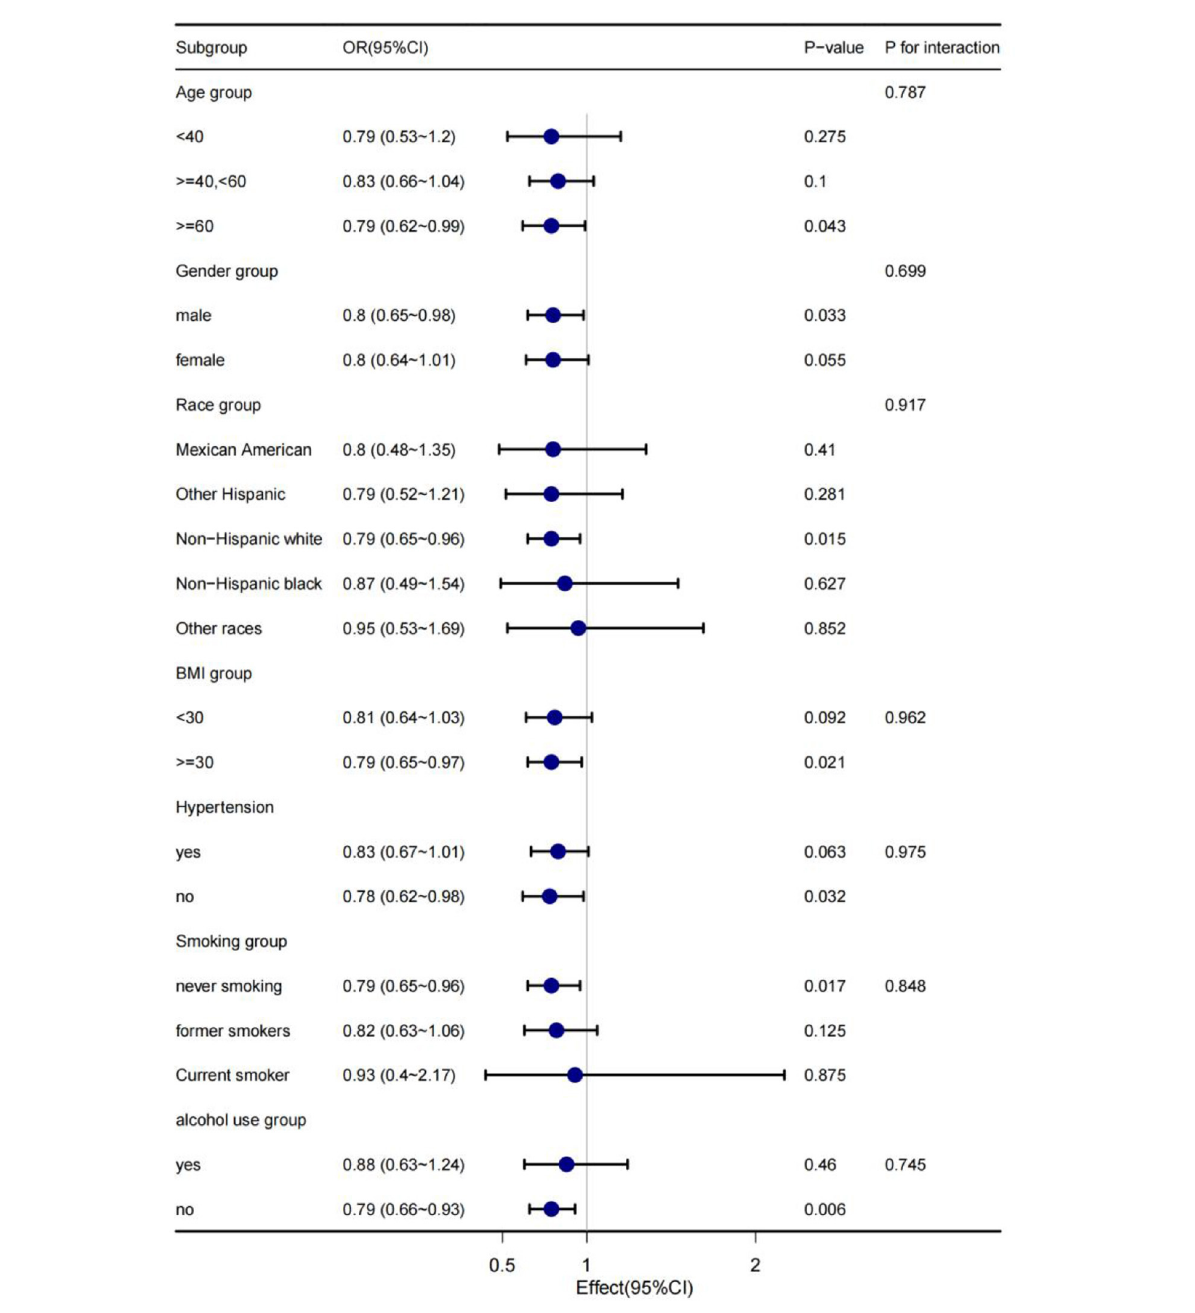
FIGURE4 The stratification logistics regression analysis of the associations of serum cadmium levels in low cadmium exposure with diabetes in different subgroup.